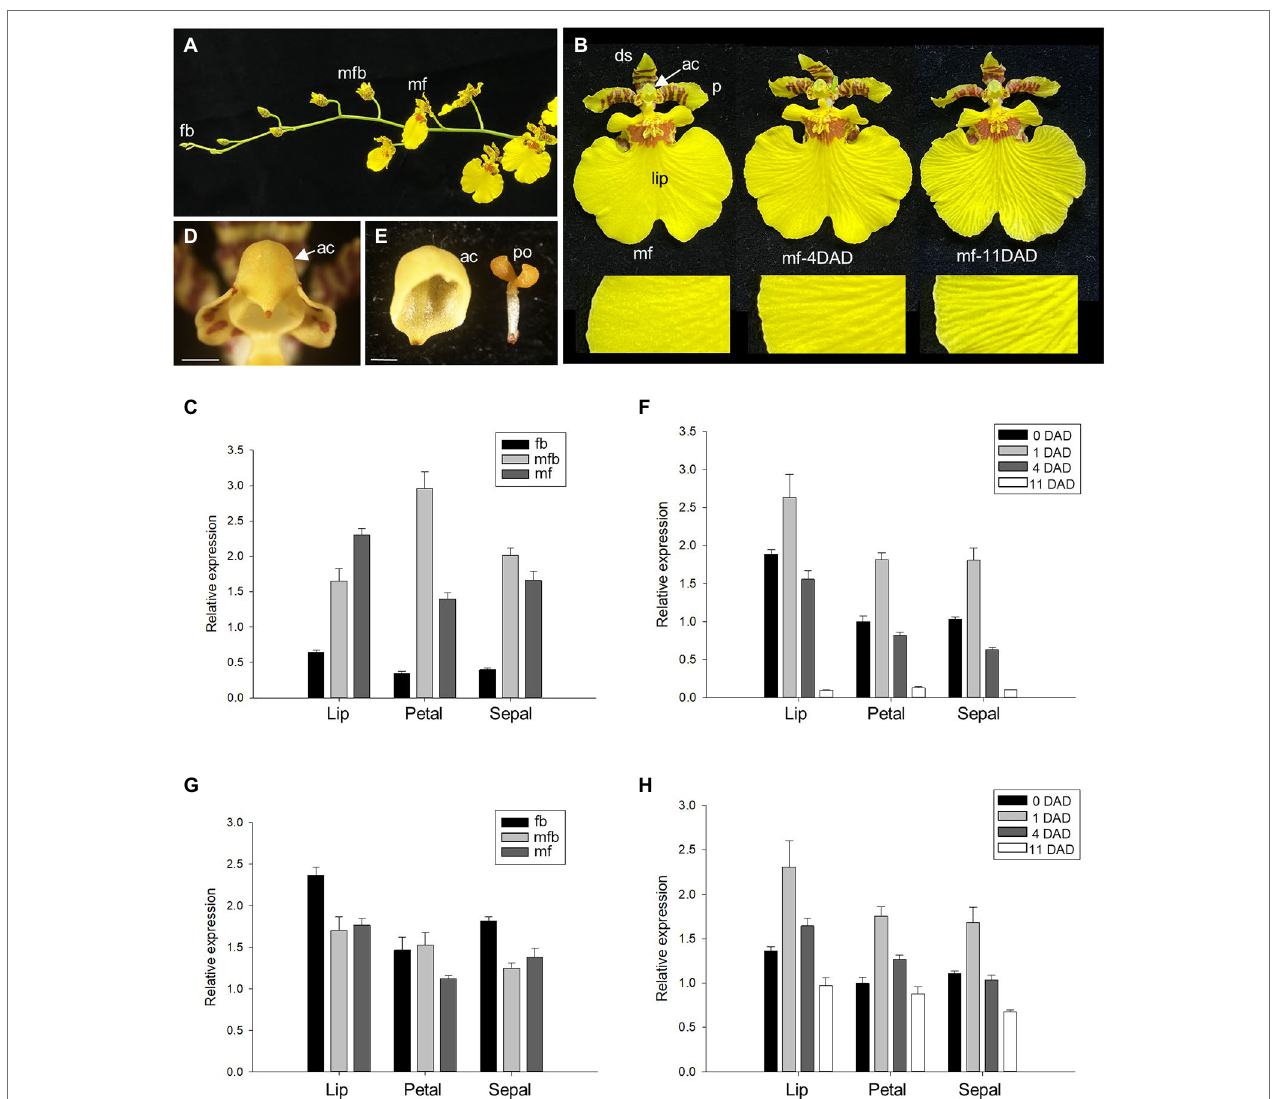
FIGURE 1 | Detection of the expression of Oncidium ACC synthase 12 ( OnACS12 ) and Oncidium ETR1 ( OnETR1 ) during Oncidium flower development. (A) Flower buds (fb), mature flower buds (mfb), and mature flowers (mf) along an Oncidium inflorescence. (B) Mature Oncidium flower (mf) with the anther cap (ac) attached (left), and 4 days [middle, mf-4 days after anther cap detachment (DAD)] or 11 days (right, mf-11 DAD) after the anther cap detached. A close-up of the lips (lip) is shown at the bottom. p; petals, ds: dorsal sepals. (C,G) Detection of the expression of OnACS12 (C) and OnETR1 (G) in the lips, petals, and sepals of Oncidium fb, mfb, and mf by real-time quantitative PCR. (D) Close up of the anther cap (ac) from ( B , left). Bar = 0.8 mm. (E) Close up of the detached anther cap (ac) and pollinium (po). Bar = 0.6 mm. (F,H) Expression of OnACS12 (F) and OnETR1 (H) in the lips, petals, and sepals of flowers 0, 1, 4, and 11 DAD as detected via real-time quantitative PCR. In (C,F,G,H) , the transcript levels of the genes were determined using two to three replicates and were normalized to the OnUBQ gene. The error bars represent